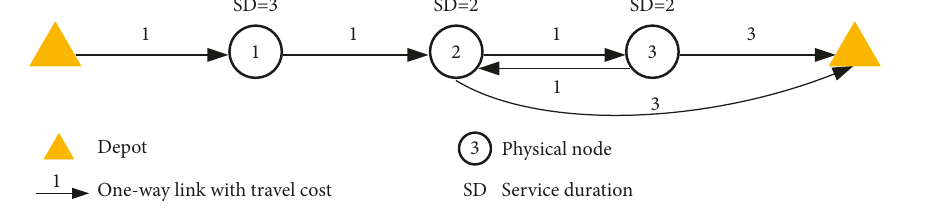
Figure 3: Physical network for a 3-node example. Table 3: Basic information of requests in the 3-node